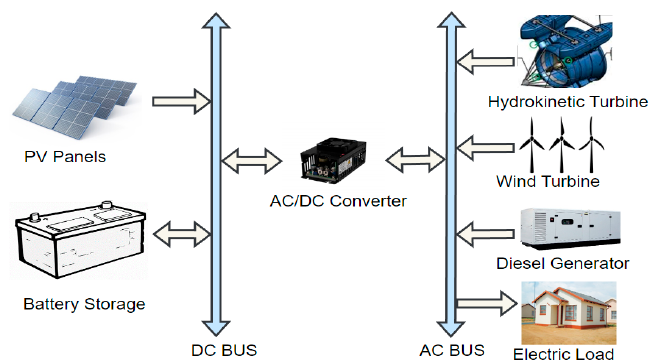
Figure 3. Schematic depiction of a HRES.